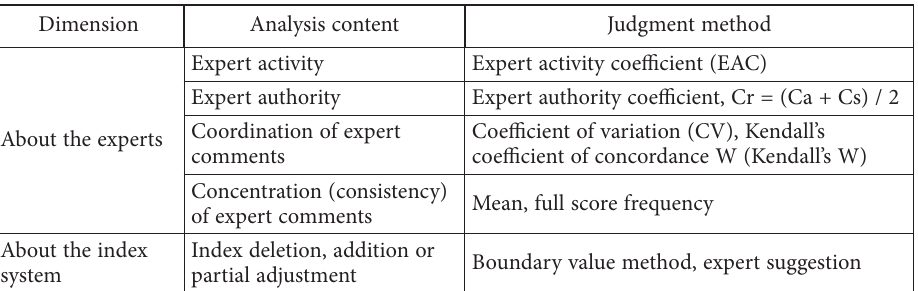
Table 3. Contents and judgment methods of data